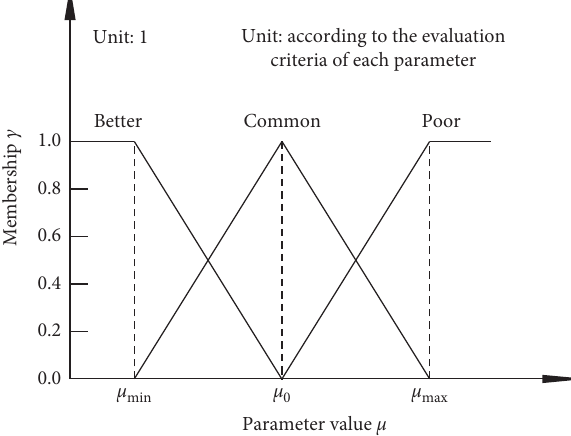
Figure 3: Model of membership in the triangular